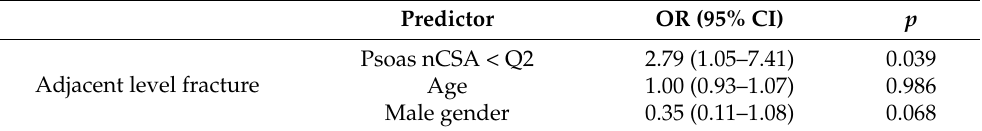
Table 3. Multivariable analysis for independent predictors of adjacent level fracture.